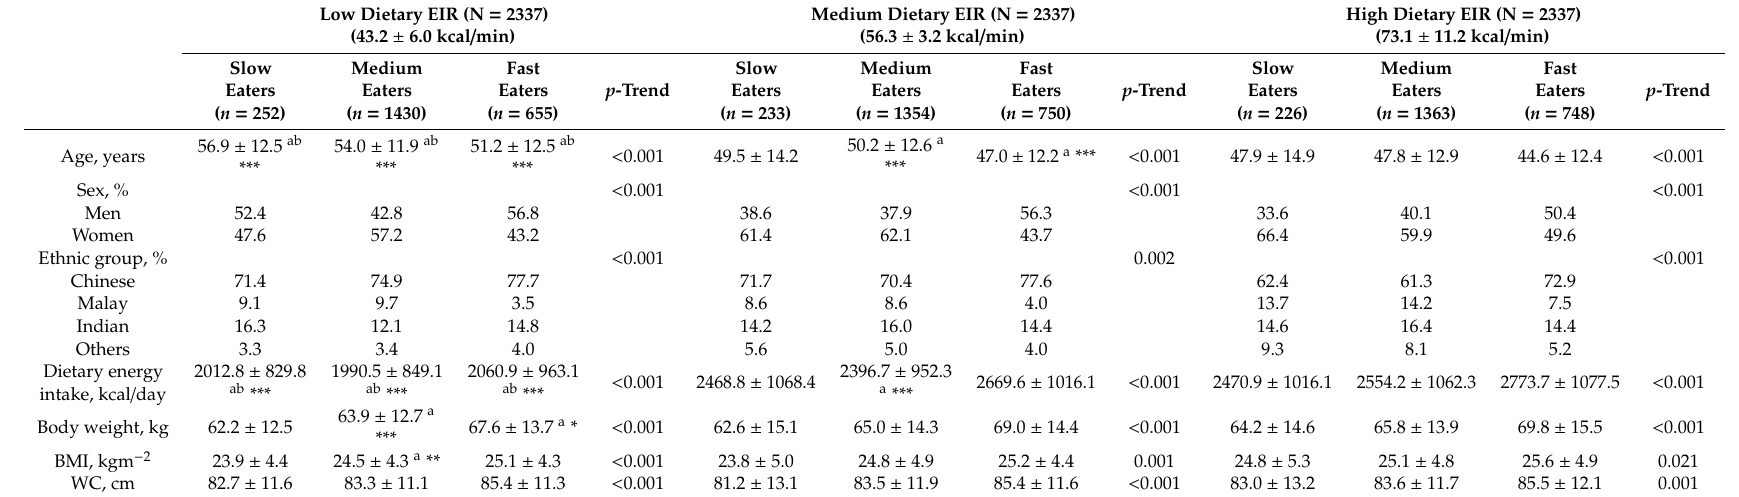
Table 1. Characteristics of participants according to self-reported eating rate (SRER) across the tertiles of dietary energy intake rate (EIR) in the Singapore Multi-Ethnic Cohort 2 ( n = 7011) 1